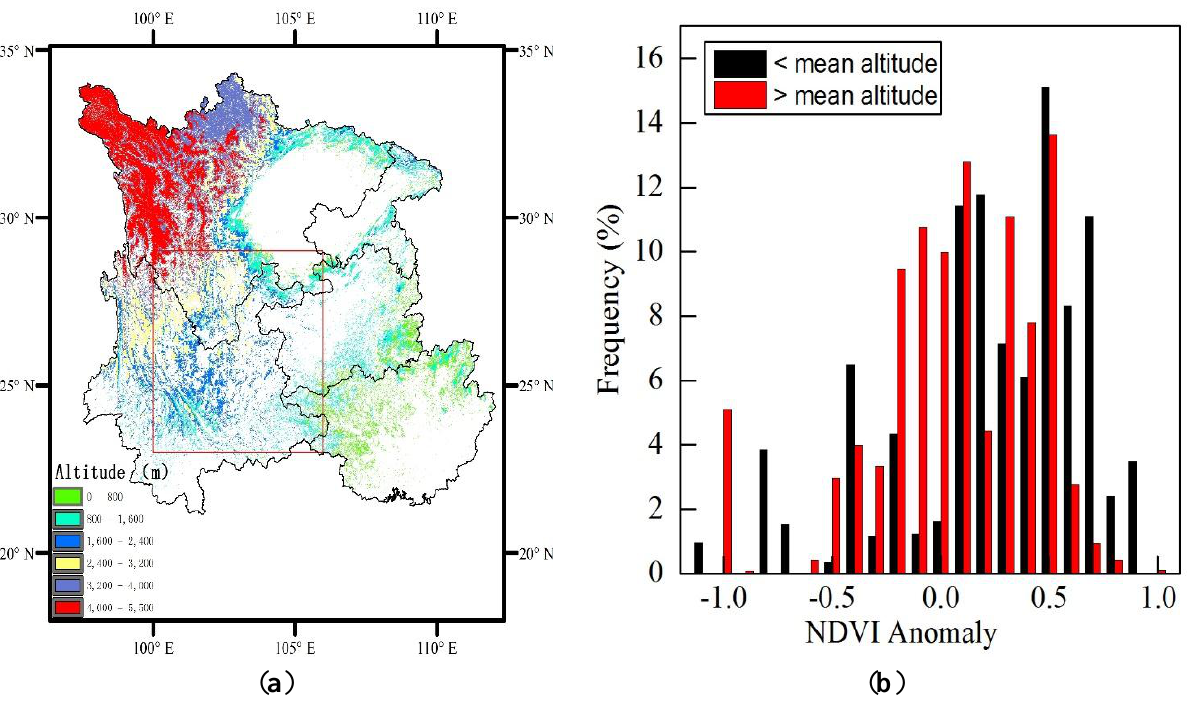
Figure 6. ( a ) Spatial distribution of altitude; and ( b ) NDVI anomaly distribution frequency of the mixed forest in the initial